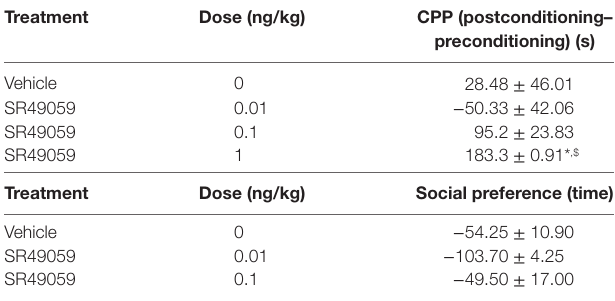
TaBle 1 | Effect of SR40059 on different behaviors in zebra fish.